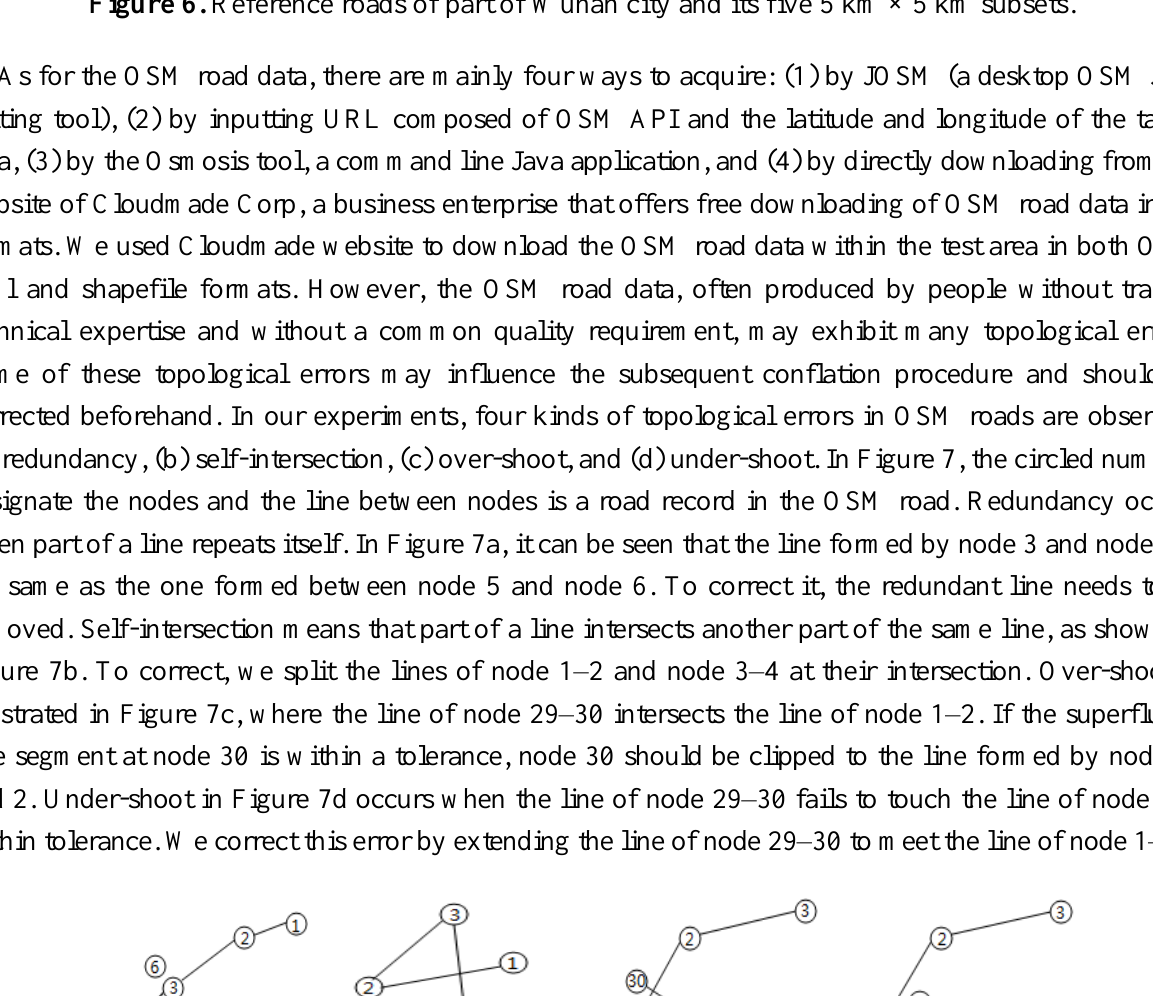
Figure 6. Reference roads of part of Wuhan city and its five 5 km × 5 km subsets.